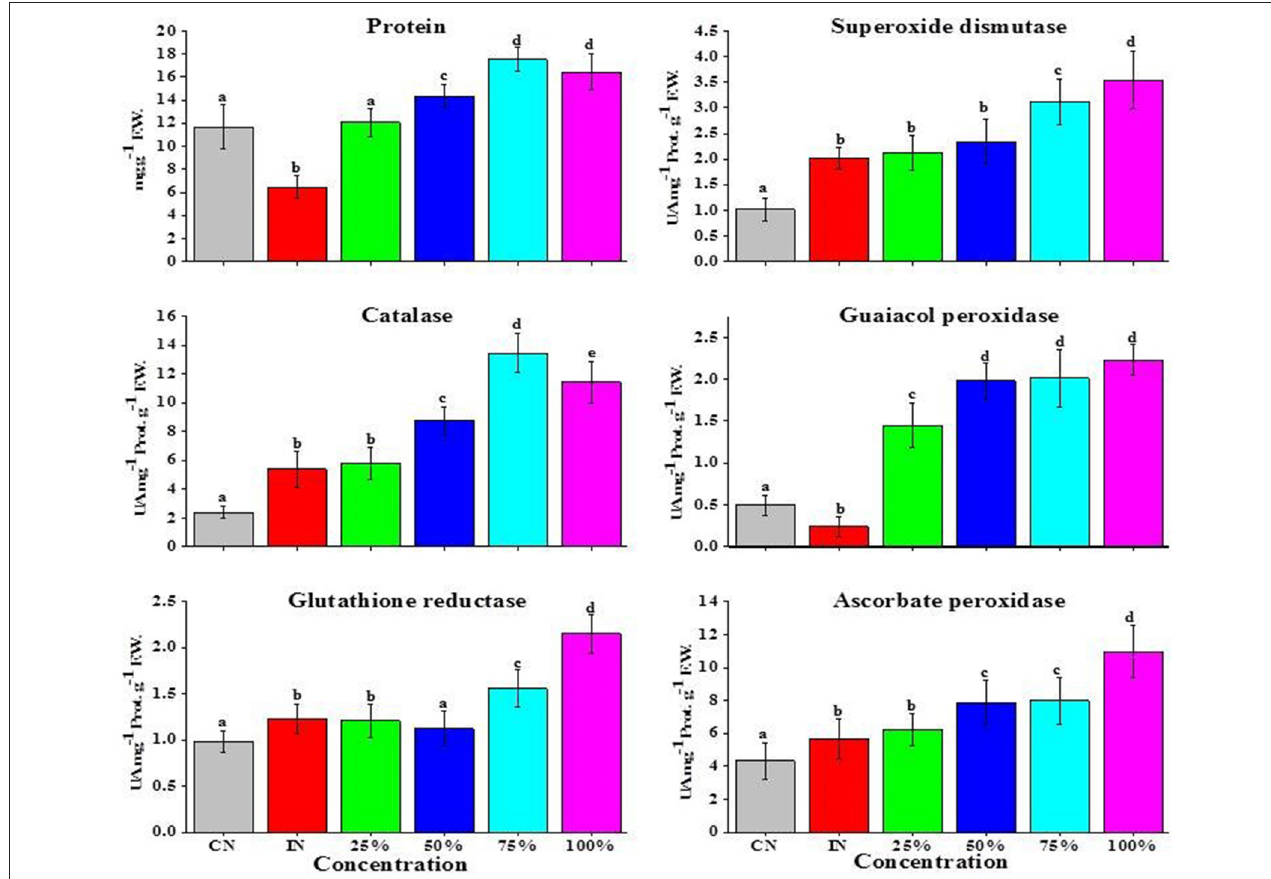
FIGURE 3 | Effects of essential (EO) of Z. armatum DC on PR (mg g − 1 FW) and specific activities (UA mg − 1 protein g − 1 FW) of SOD, CAT, GPOX, GR, and APX of tomato fruits inoculated with A. alternata . CN, control; IN, inoculated; 25, 50, 75, and 100% indicate concentrations of EO used. Values represent mean ± standard error, where number of biological repeats is five ( n = 5). Different letters (a–d) indicate significant differences from each other in all combinations at p <